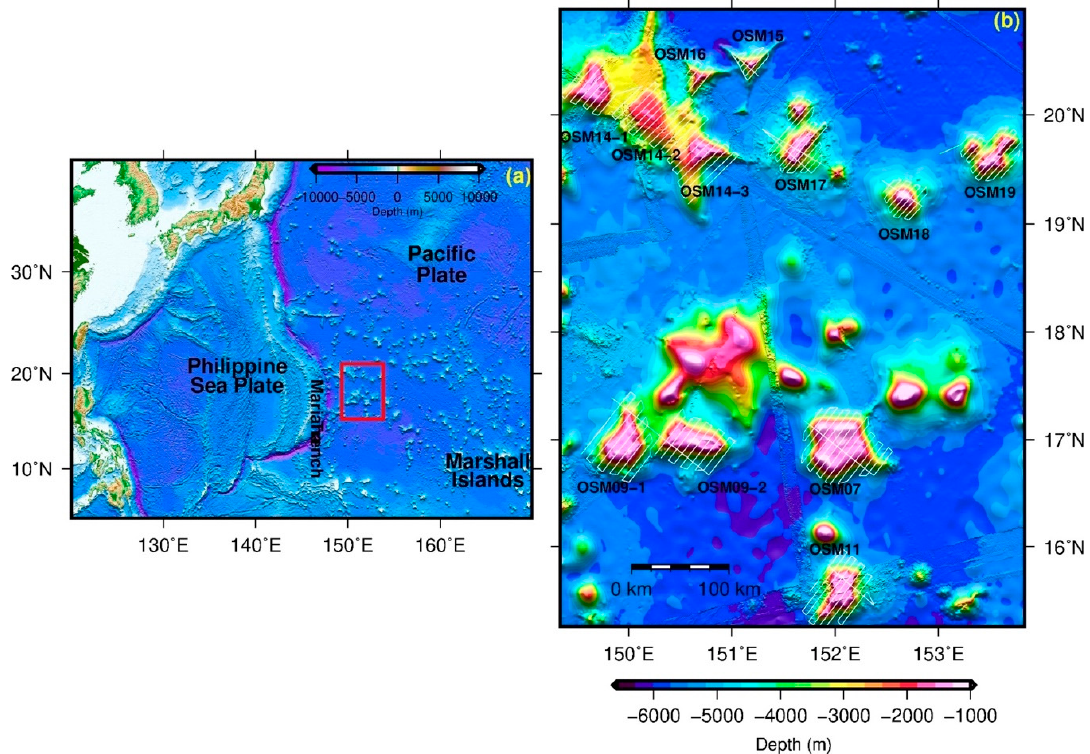
Figure 1. ( a ) Reginal bathymetry map of the study site in the Western Pacific. The study area is denoted as the red box; ( b ) bathymetric map of the study area showing a compilation of Simrad multibeam data of R/V Onnuri and predicted data from Ryan et al. [38]. White dashed lines are the ship tracks of R/V Onnuri.